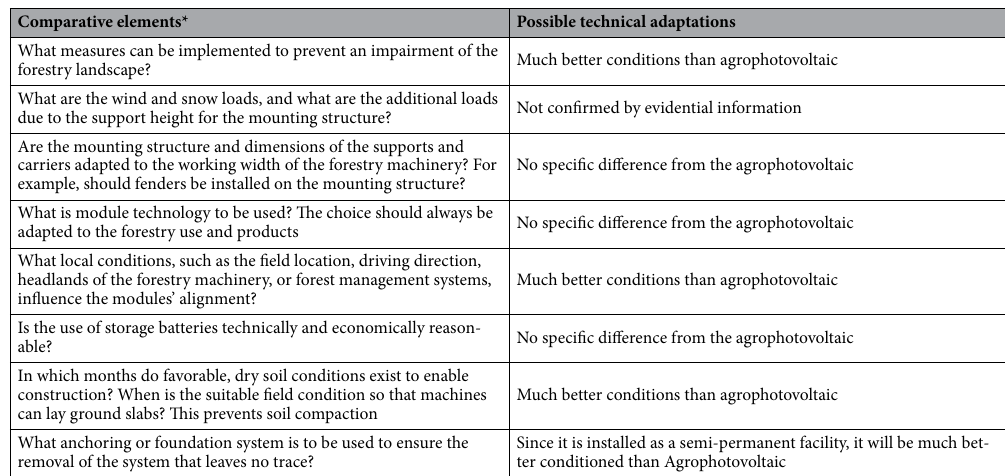
Table 5. Comparative evaluation between the simulated forest-photovoltaic and agrophotovoltaic system in terms of possible technical adaptations. *Source: Germany: Fraunhofer ISE (2021). Agrivoltaics: opportunities for agriculture and the energy transition. A guideline for Germany 29